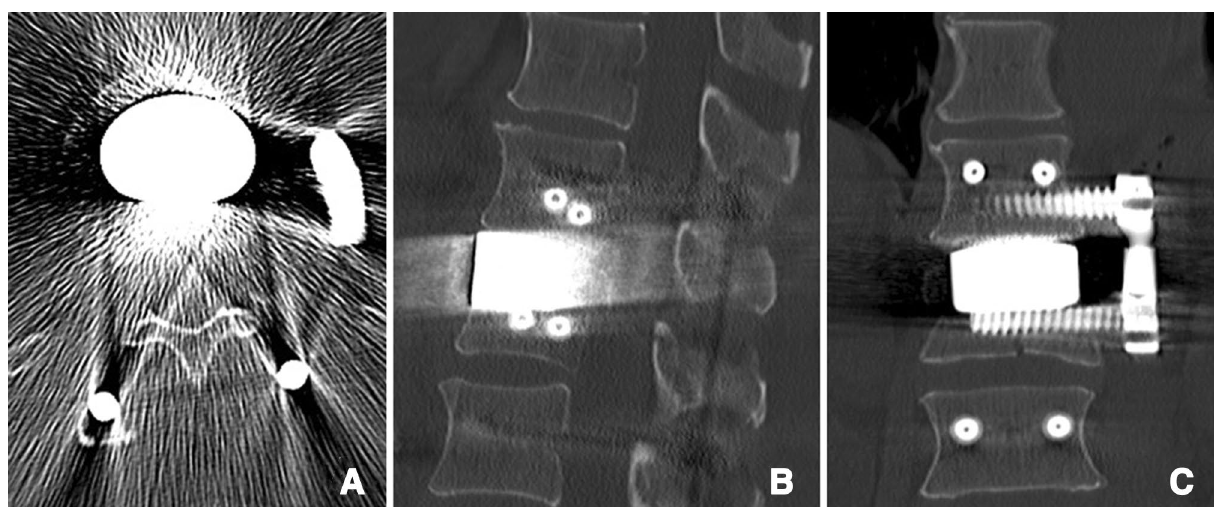
Figure 3. Postoperative CT of a 65-year-old man with a superior burst-split fracture of L1 (Magerl et al. 19 3.2.1, AOSpine A4 1 ) treated by short segment posterior instrumentation and anterior one-level spondylodesis using a porous tantalum fusion implant (PTFI). Representative axial ( A ), sagittal ( B ) and coronal ( C )